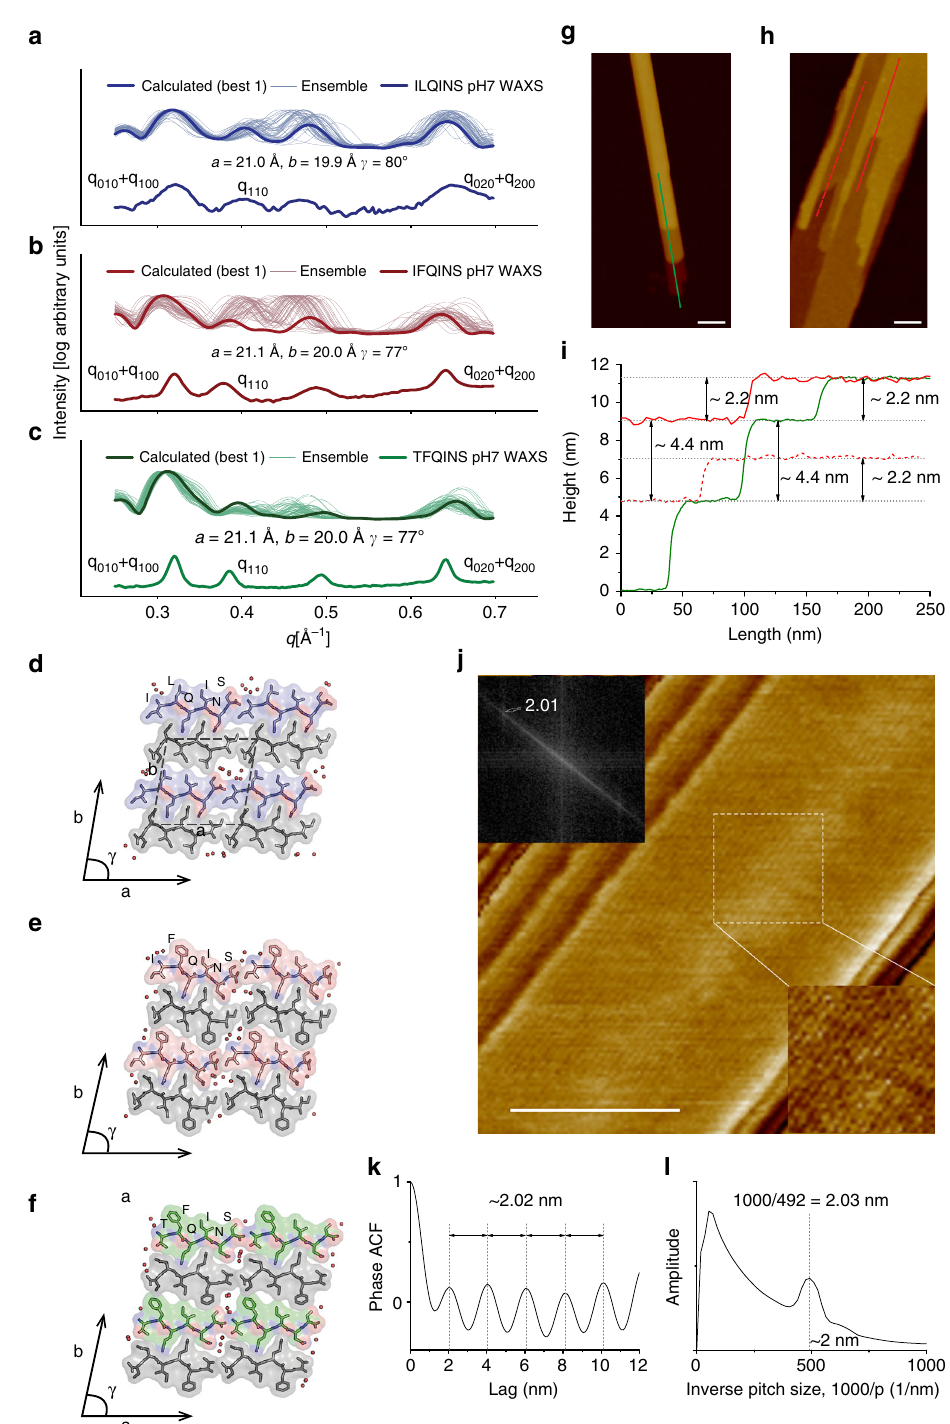
Fig. 3 WAXS, AFM and MD simulations shed light on the molecular organisation in the amyloid unit cell. a – c Shows calculated scattering curves based on ensembles of nanocrystals. The single curves giving the closest match to the experimental data for each peptide are highlighted, and labelled with their unit cell parameters. The central region of the spectra was highly variable with respect to γ in comparison to the two large peaks at each end. d – f show the nanocrystal structures associated with each closest-matching trace, with semi-ordered dynamic water molecules shown as orange spheres. AFM images of g TFQINS ( Z -scale = 30 nm) and h IFQINS ( Z -scale = 30 nm) with i the corresponding height pro fi les showing that the height of one single layer is 2.2 nm. j AFM phase images of TFQINS showing lateral periodicity of ca. 2 nm (FFT inset in left corner). Scale bars are 50 nm. k , l show the evaluation of lateral periodicity by k averaged ACF of phase image and l DFT analysis of phase images